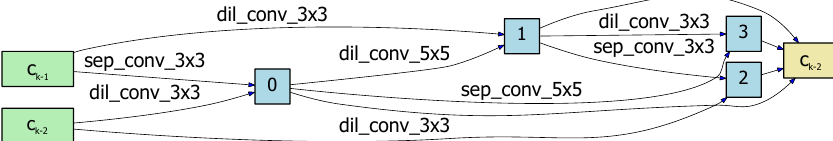
Figure 5. The reduction cell searched by NAS-HRIS on